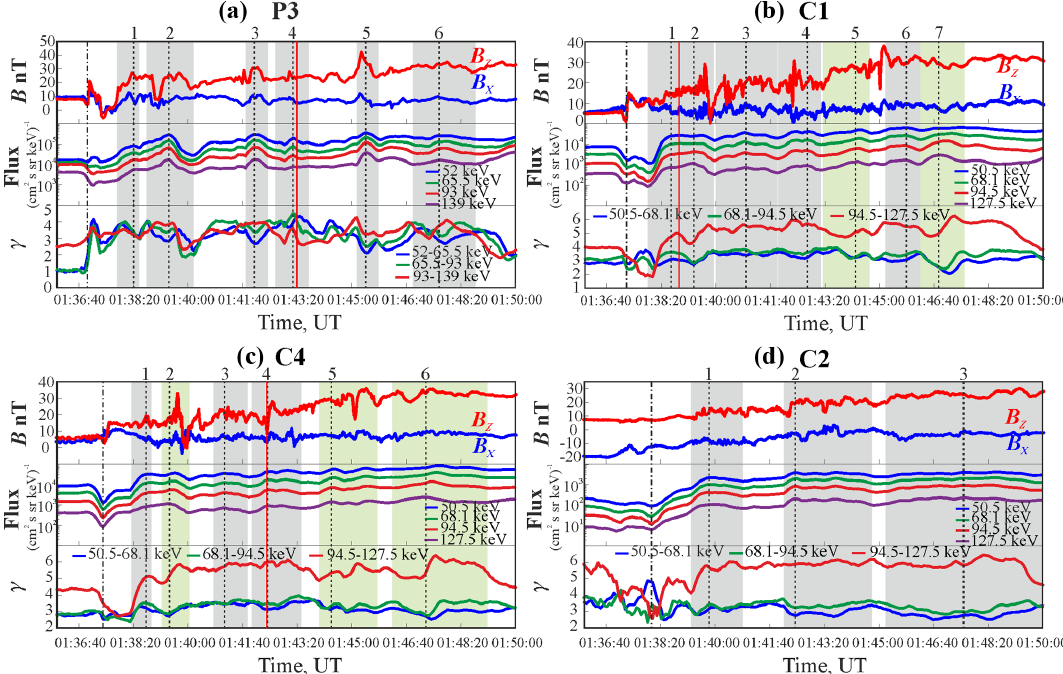
Figure 3. The dynamics of suprathermal electron fluxes and spectral index γ observed by P3, C1, C4 and C2 satellites. In each plot the following data from a given spacecraft are shown from top to bottom: the time profiles of B X and B Z magnetic field components, the time profiles of electron fluxes in several energy ranges and the spectral index γ calculated for three energy ranges indicated in the corresponding panel . The time moment of dipolarization onset at each spacecraft is shown by the vertical dashed and dotted line. The intervals of dispersed injections are shaded light green and the intervals of dispersionless injections are shaded grey. The moments of peak electron flux observations in each injection are indicated by vertical dashed lines. The moments of γ variations which cannot be explained by the time-of-flight energy dispersion are indicated by red solid vertical